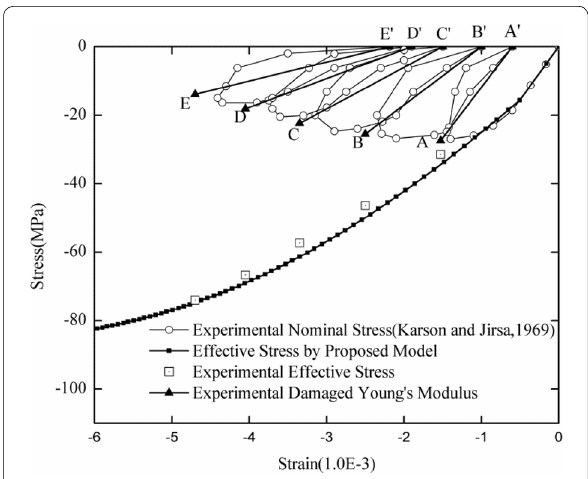
Fig. 5 Experimental stress–strain curves in the effective and nominal configurations for Karsan and Jirsa (1969) experimental data.